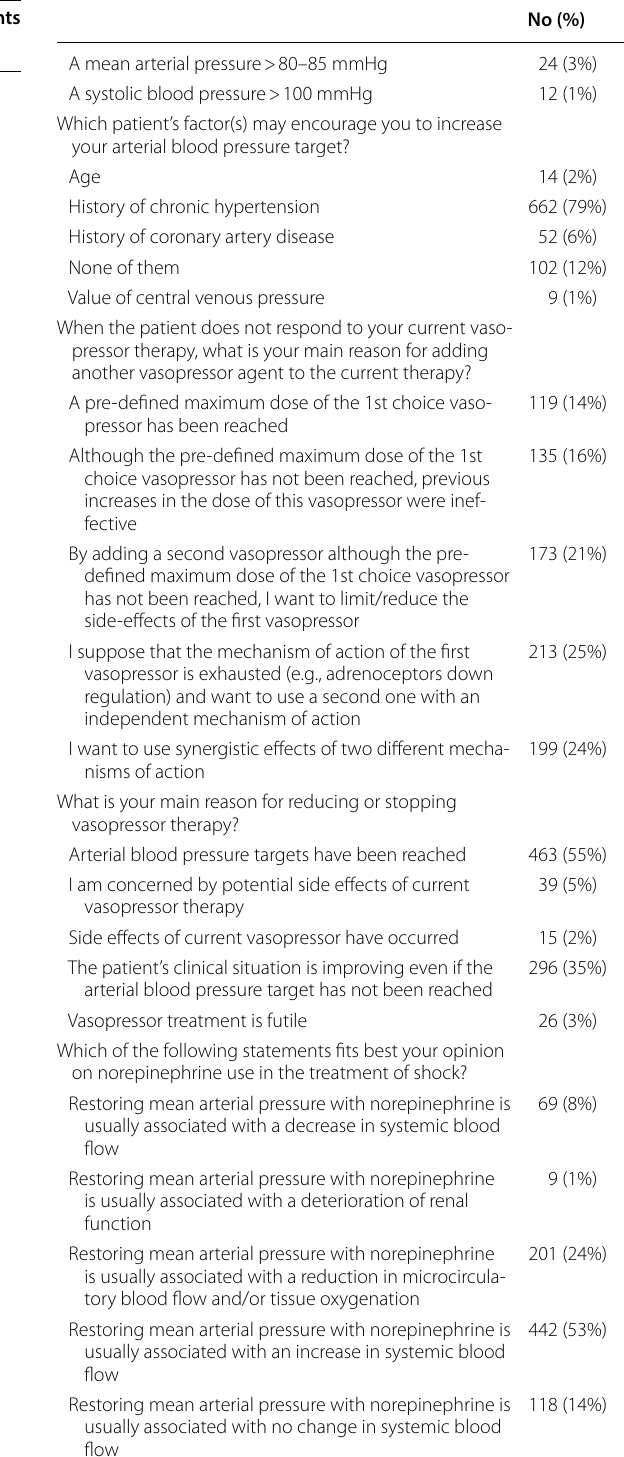
Table 2 Survey questions and answers on vasopressor use in septic